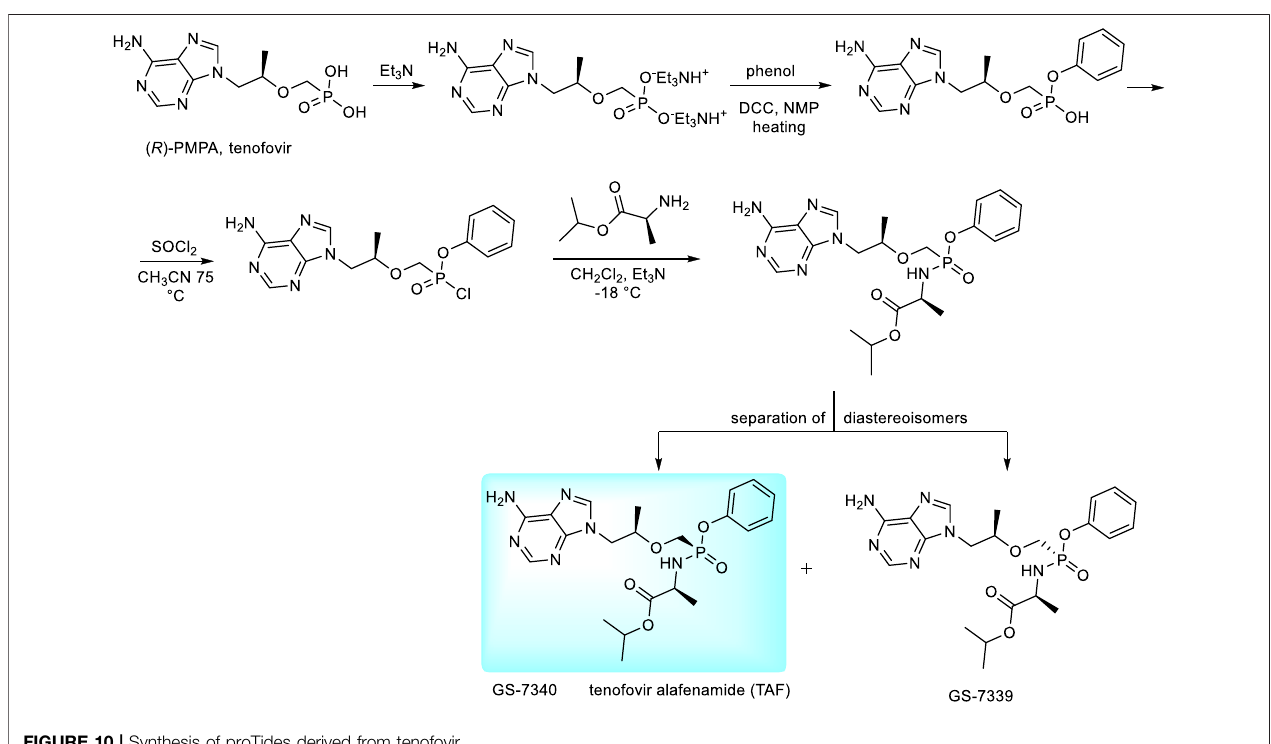
FIGURE 10 | Synthesis of proTides derived from